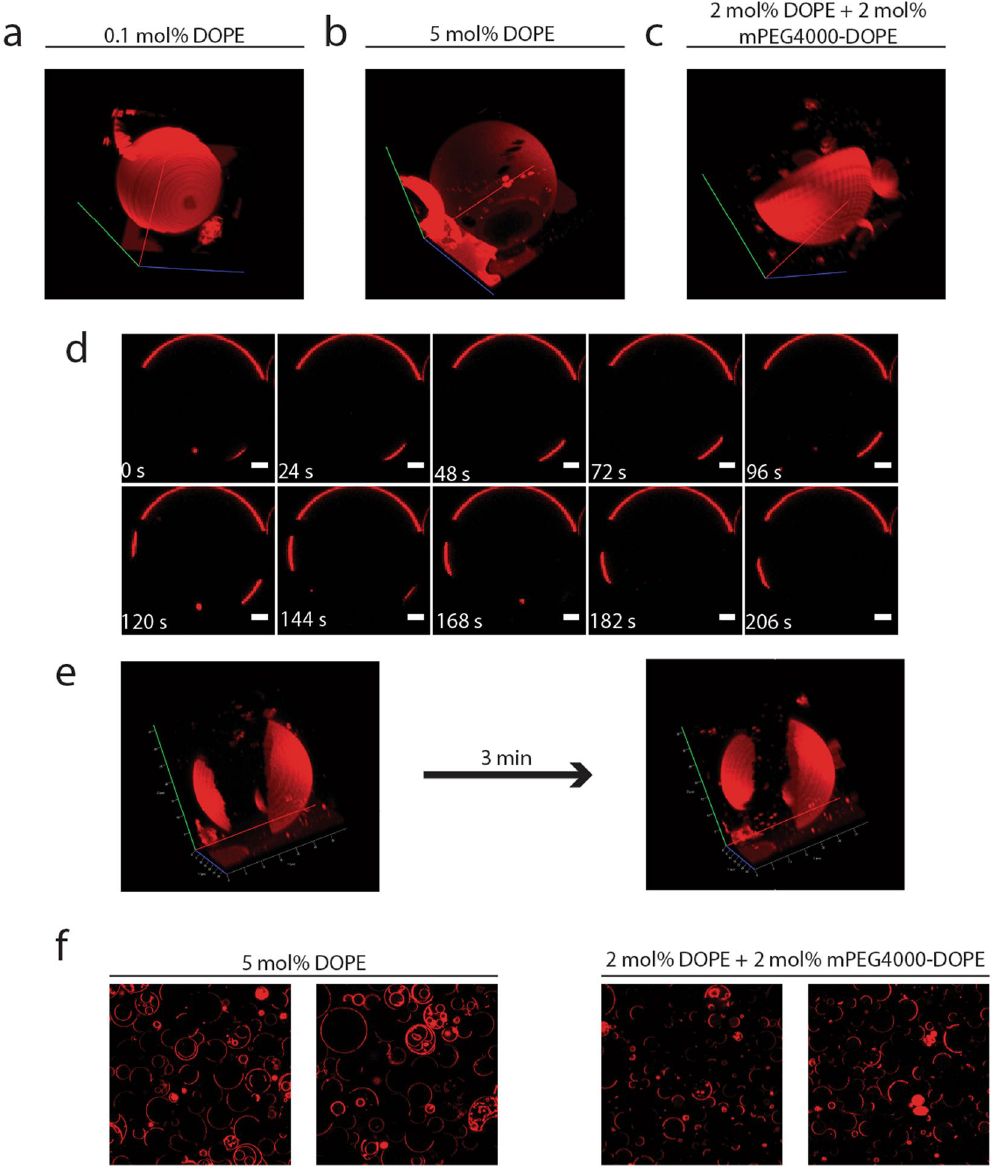
Figure 6. Immobilization of GUVs. Panels a–c show 3D images of GUVs composed of DPPC/DOPC/ Cholesterol|(4/3/3) with addition of various amounts of DOPE: 0.1 mol% ( a ) or 5 mol% ( b ), or 2 mol% of DOPE plus 2 mol% mPEG4000-DOPE ( c ). Panels d and e show movement of large lipid domains in 2D over a period of 4 min ( d ); scale bar is 5 µ m) and in 3D ( e ). Panel f shows the influence of mPEG4000-DOPE on the stability of the